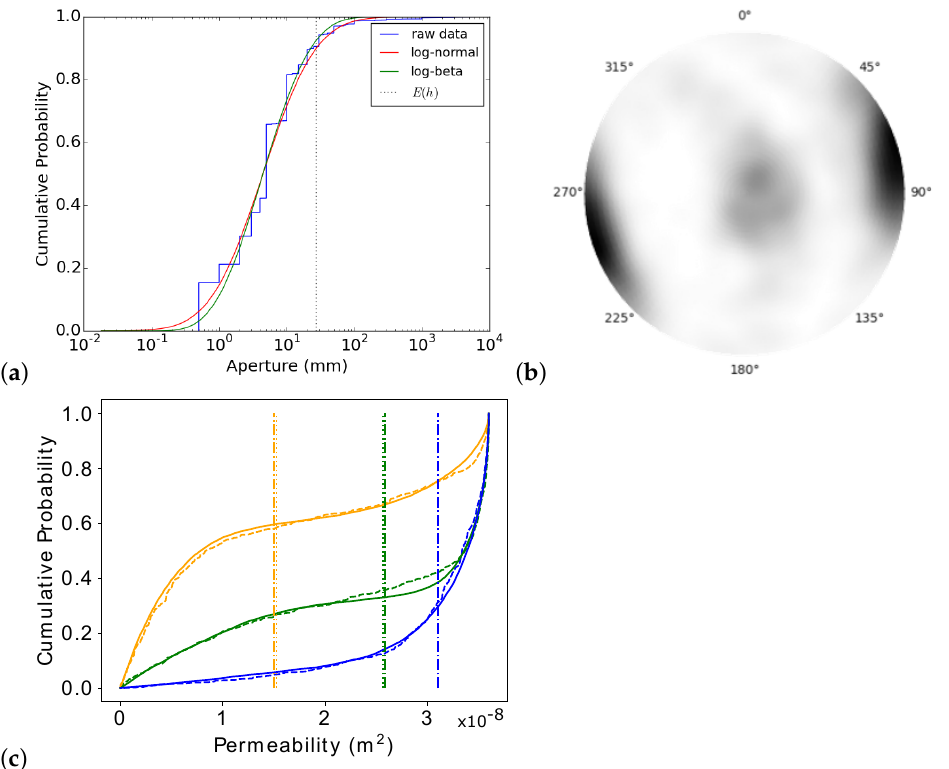
Figure 1. The distribution of fracture properties: ( a ) Log-normal and log-beta distributions fitted to the raw data; ( b ) a stereonet of the distribution of fracture orientations dominated by vertical fractures; ( c ) the permeability distribution of each fracture axis accounting for the distribution of apertures and